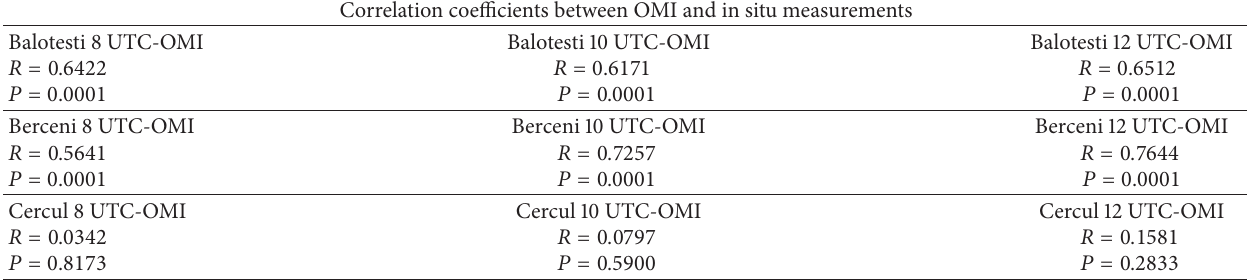
Table 3: Correlation coefficients (top) between OMI and in situ measurements of the NO three locations: rural, industrial, and